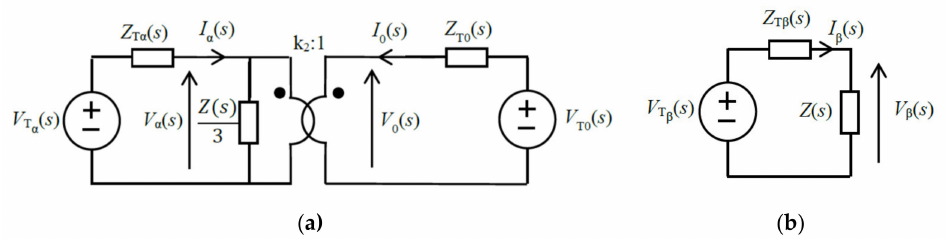
Figure 7. Connection of Thevenin modal circuits in the Laplace domain. Line switching of phases b and c results in ( a ) coupled α and 0 circuits through an ideal transformer with ratio k 2 = − 1/ ( b ) an uncoupled circuit β